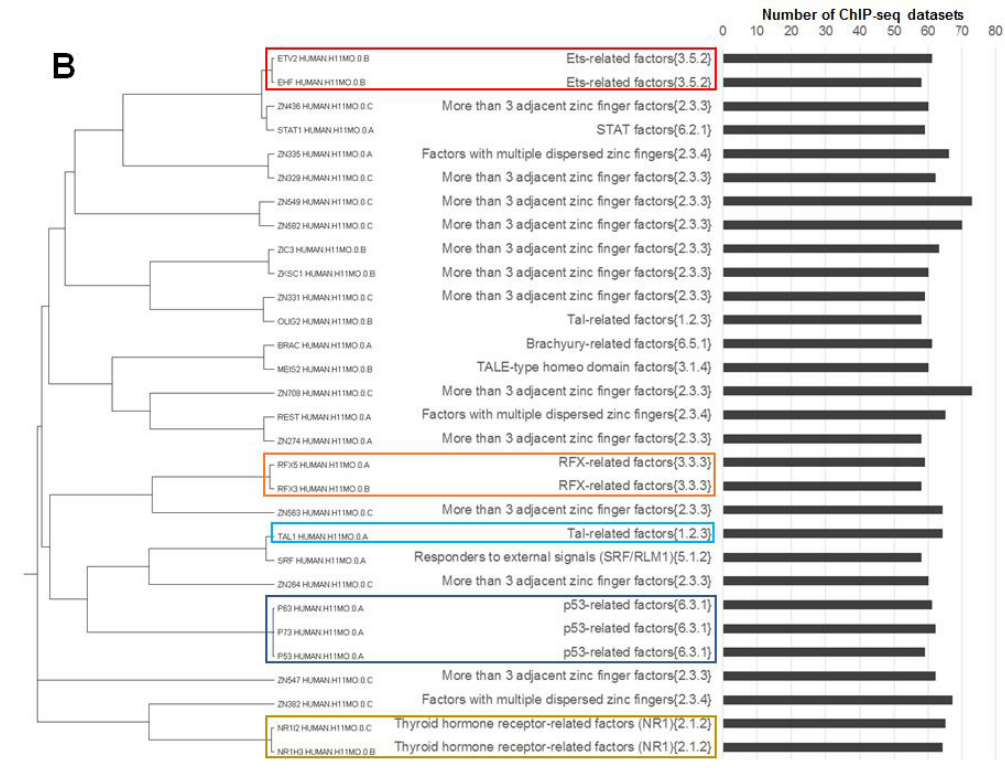
Figure 7. Clustering of the 30 top-ranked partner motifs from the Hocomoco human core collection [14] according to their abundance in CEs predicted with an overlap of anchor motifs. We excluded from the analysis CEs containing the significant homology between motifs. Panels ( A , B ) show results for CEs with more conserved anchor and partner motifs, respectively. For each panel the left / middle / right columns show the tree constructed according to motifs homology, names of TF families [13] and the distribution of the number of ChIP-seq datasets that contained the respective CEs. Brown, green, red, orange, blue, cyan and aqua boxes mark NR1H3-like motifs from the thyroid hormone receptor-related factors (NR1) {2.1.2} family, Jun-like (Maf-related factors {1.1.3}), ETS-like (ETS-related factors {3.5.2}), RFX-like (RFX-related factors {3.3.3}, p53-like (p53-related factors {6.3.1}), THAP-related factors {2.9.1} and GATA-like (Tal-related factors {1.2.3}) motifs, respectively. Totally, we included in the analysis 119 ChIP-seq datasets for human TFs (Table S1).